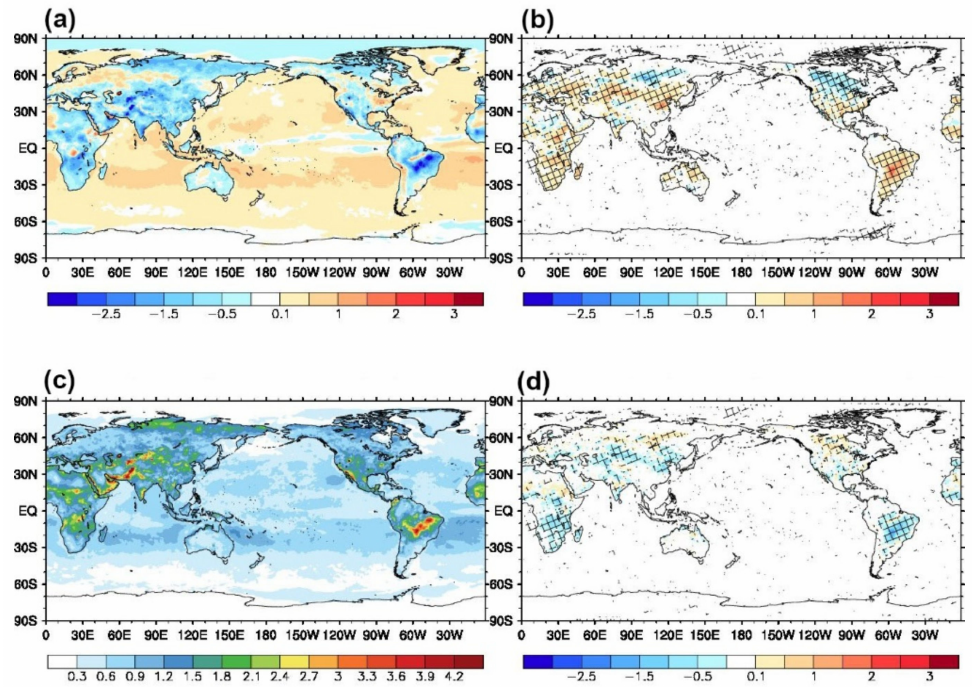
Figure 6. ( a ) Biases and ( c ) RMSEs of 2-m-specific humidity in the CTL against the ERA5 reanalysis, and ( b ) differences in the biases and ( d ) RMSEs between the EXP and CTL over the period of 1 July 2019 to 10 August 2019 for the analysis field. The hatched regions indicate a difference significant at the 95% confidence level.